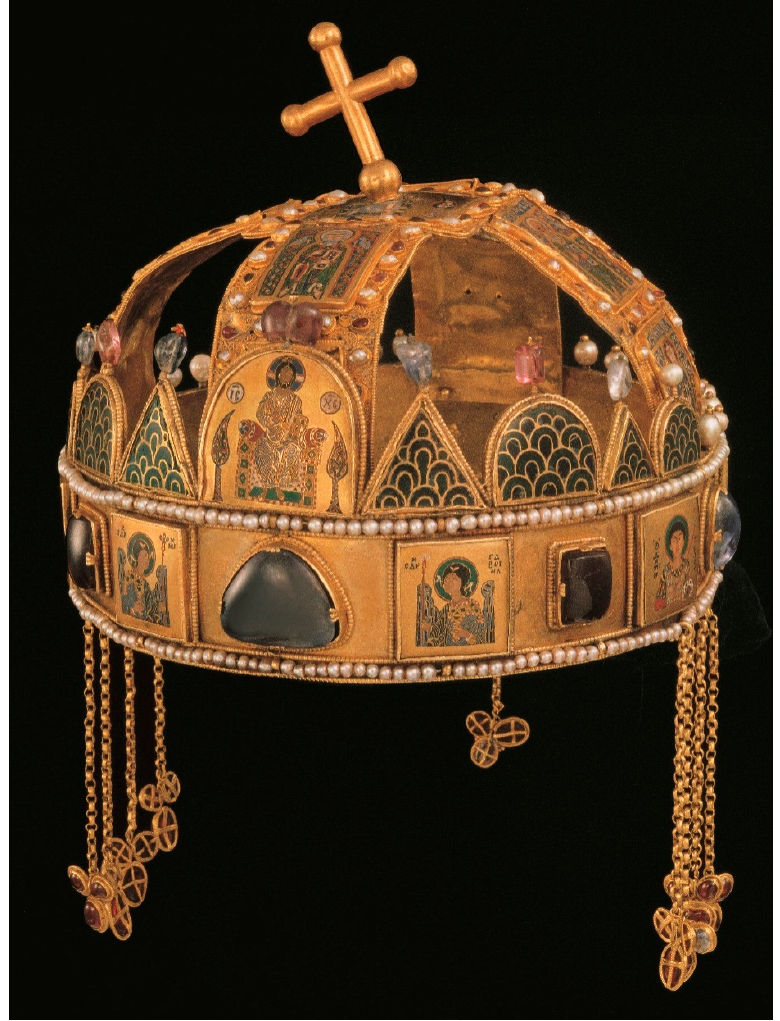
Figure 1. The Holy Crown of Hungary. Photo courtesy of the Holy Crown Research Group of the Hungarian Academy of Sciences, copyright Károly Szelényi.